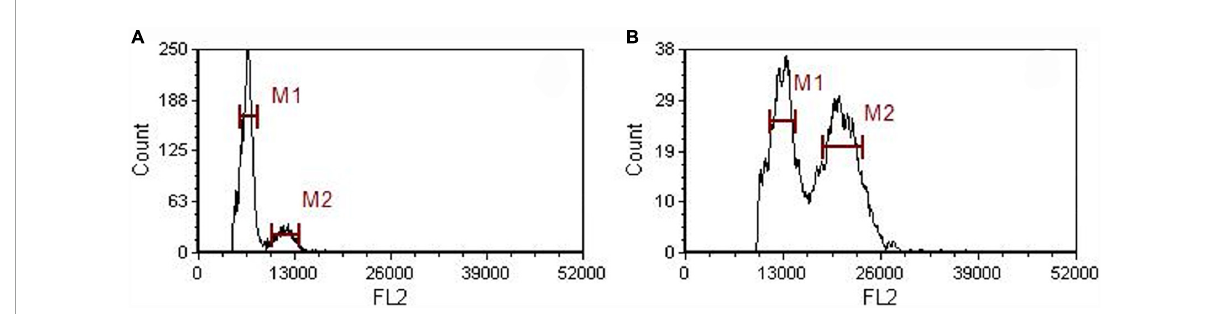
FIGURE1 Histograms showing the results of flow cytometric analysis of diploid (A) and tetraploid (B) A. roxburghii plants.